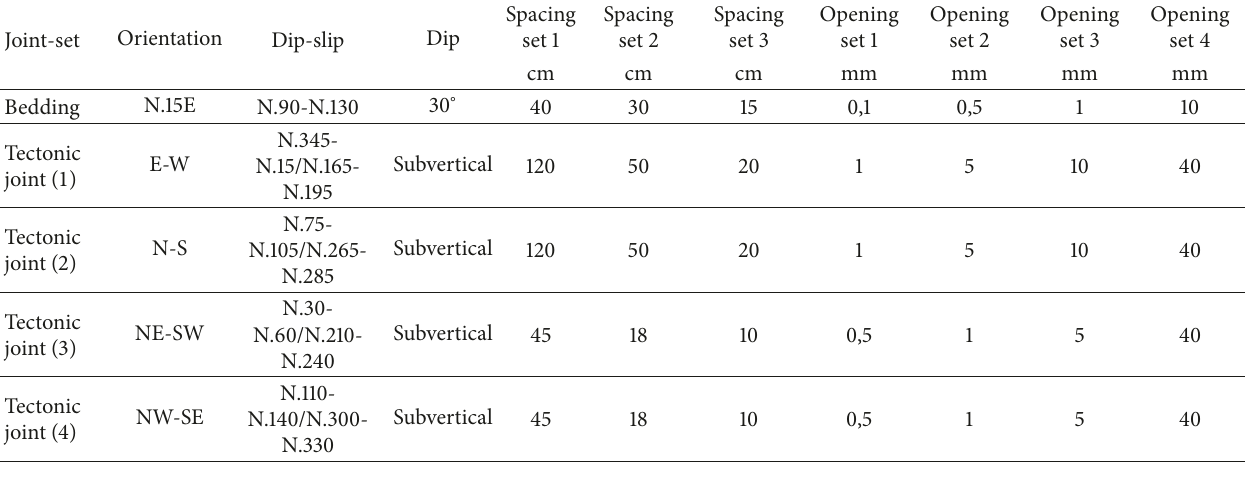
Table 1: Summary table with orientation (dip-slip, dip), spacing, and opening for the joint-set of the Cassino plain.